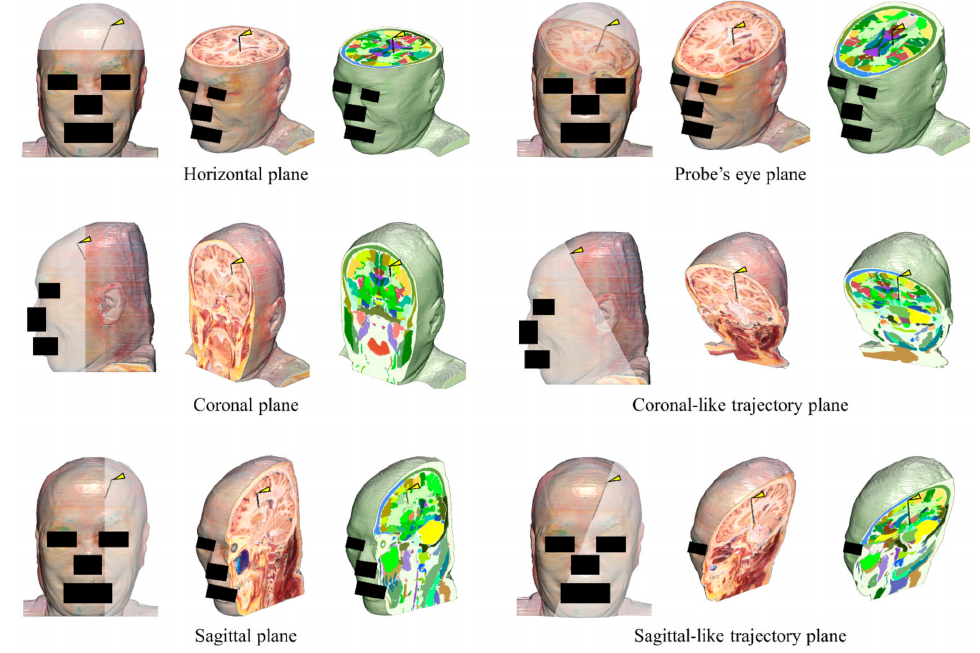
Figure 2. Various planes produced from the real volume model of sectioned images and a segmented volume model of a cadaver. The DBS electrode for the left subthalamic nucleus is displayed as an overlay. The entry point of the electrode is indicated with a yellow arrow